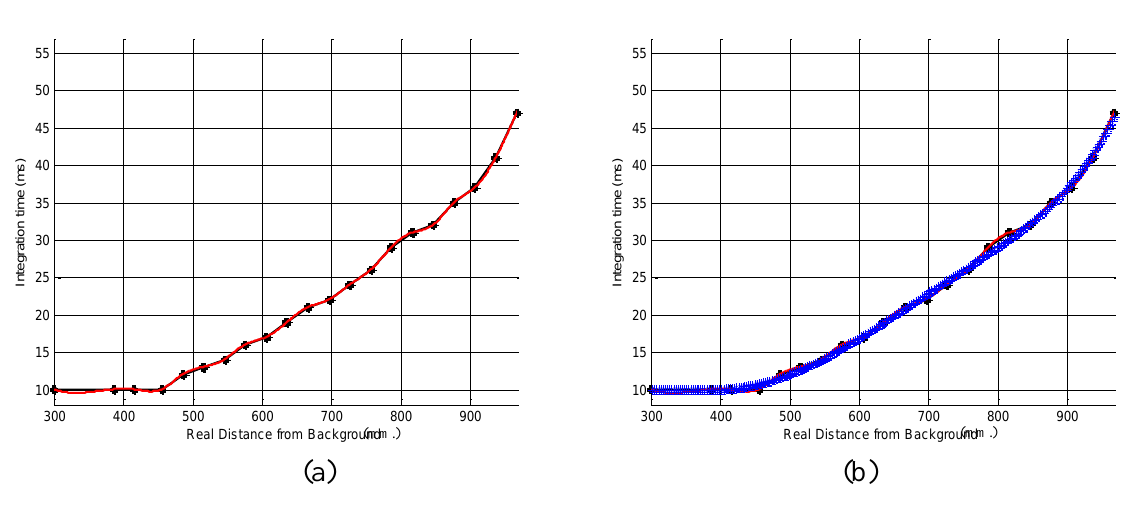
Figure 4. Polynomial interpolation applied to compute and 1 m, for the tests of Figure